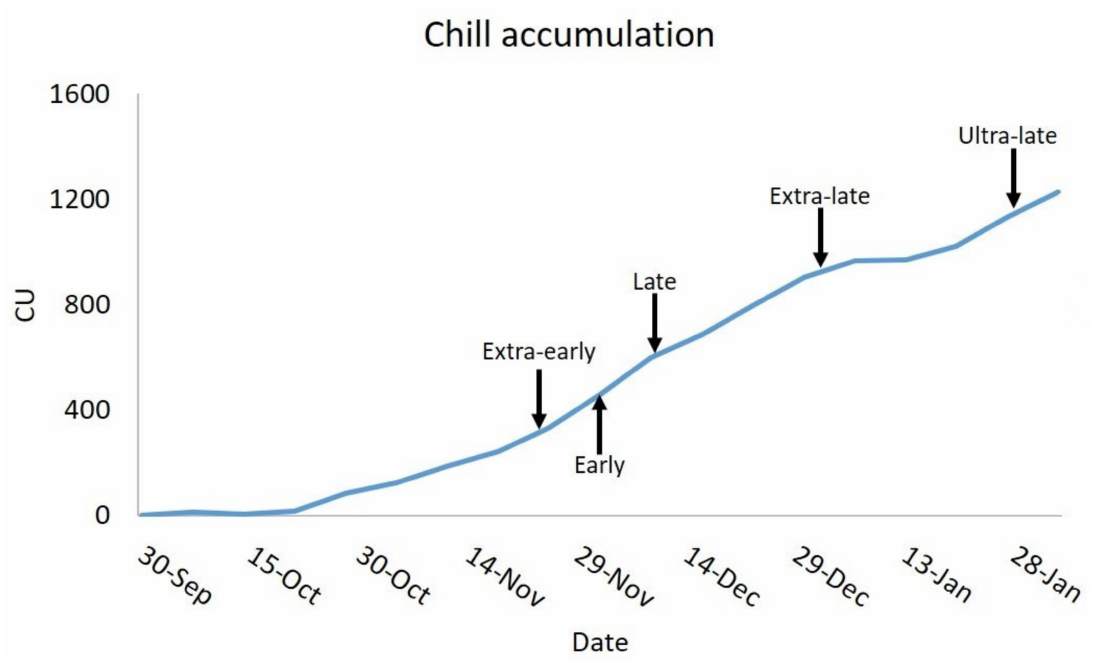
Figure 2. Chill accumulation in Barrax during the winter of 2020/21 measured using the Richardson model. The endodormancy release date for each cultivar group is marked with an arrow.